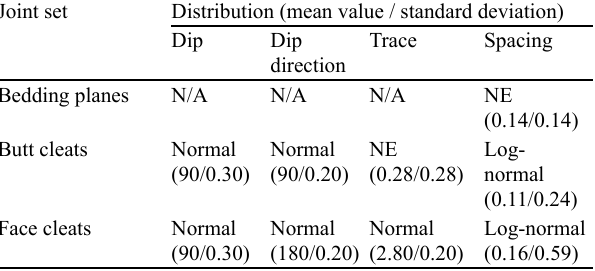
Table 1 Statistical results of coal-joint data used for DFN generation Joint set